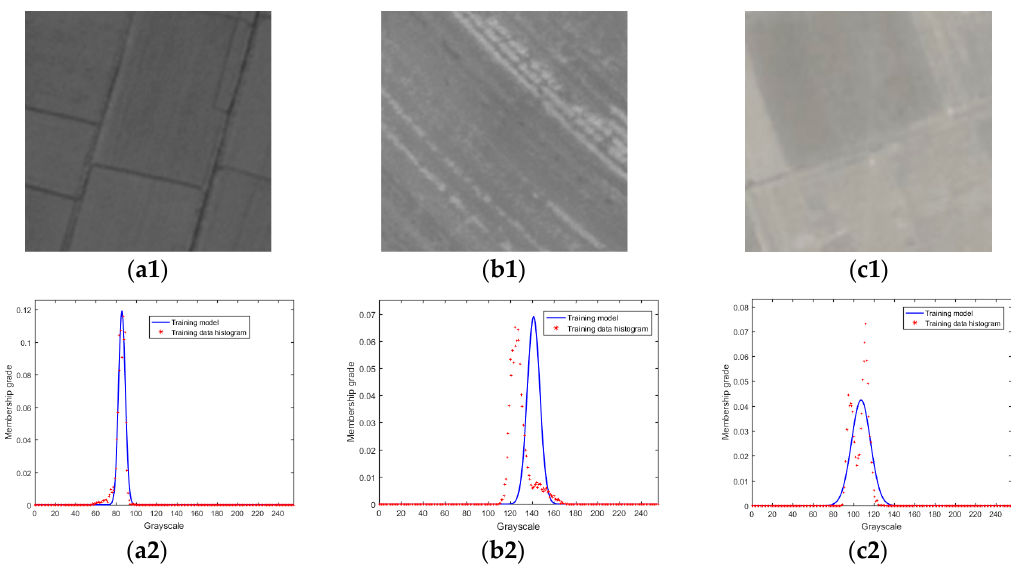
Figure 1. Farmland and corresponding fuzzy membership function model. ( a1 ) Farmland 1; ( b1 ) Farmland 2; ( c1 ) Farmland 3; ( a2 ) Fuzzy membership function model of farmland 1; ( b2 ) Fuzzy membership function model of farmland 2; and, ( c2 ) Fuzzy membership function model of farmland 3.